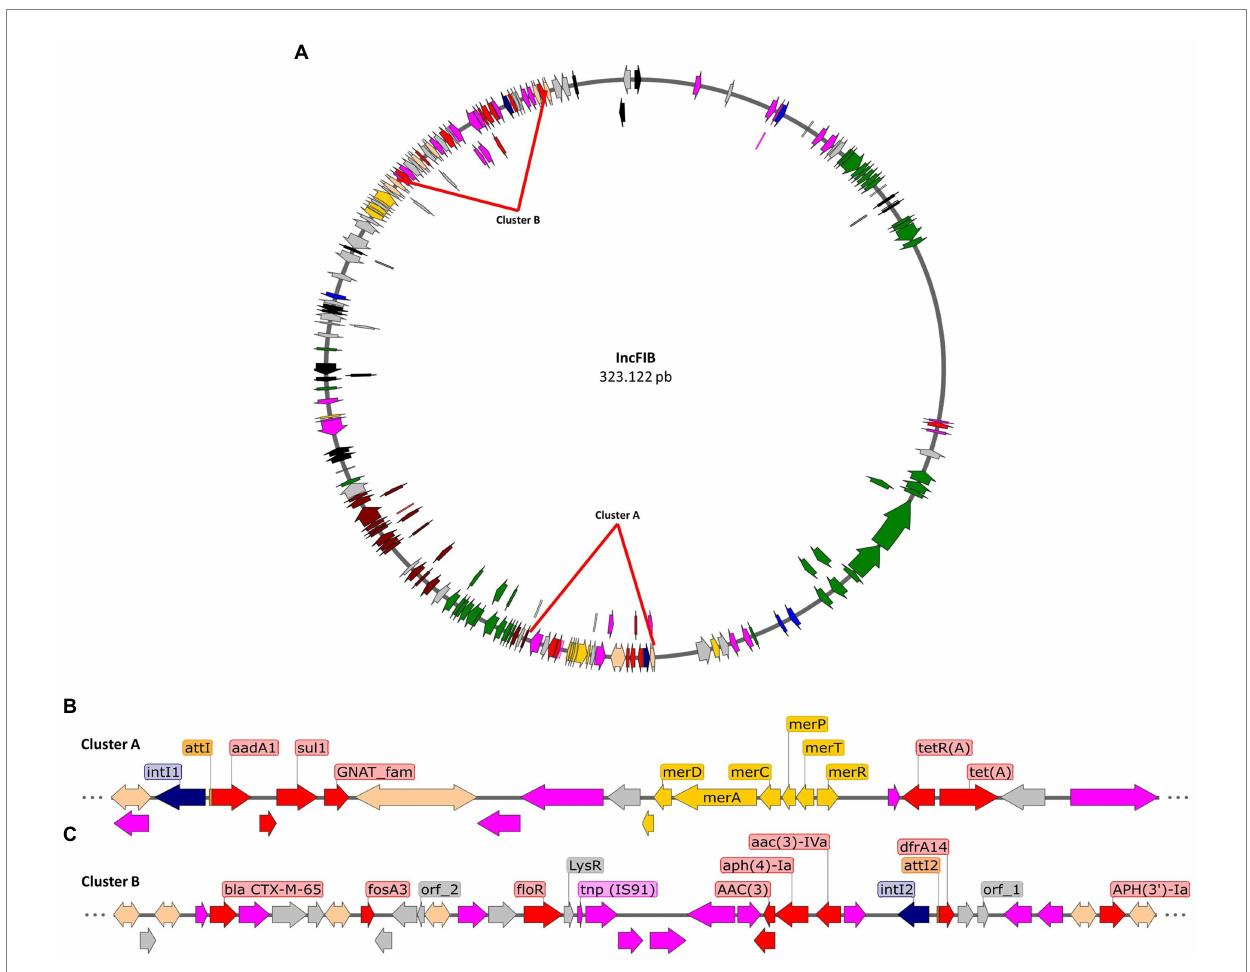
FIGURE 3 Representation of the IncFIB plasmid draft of serotype Infantis isolates. (A) Draft of the IncFIB plasmid, highlighting the position of clusters A and B that contain diverse mobile elements that include antibiotic resistance genes. (B) Genomic context of mobile and resistance elements in cluster A. (C) Genomic context of mobile and resistance elements in cluster B. Transposons in fuchsia arrows, integrases in blue arrows, sequence of integration in orange rectangles, antibiotic resistance genes in red arrows, metal resistance genes in yellow arrows, virulence genes in green arrows, conjugation genes in brown arrows, and other passenger genes in gray